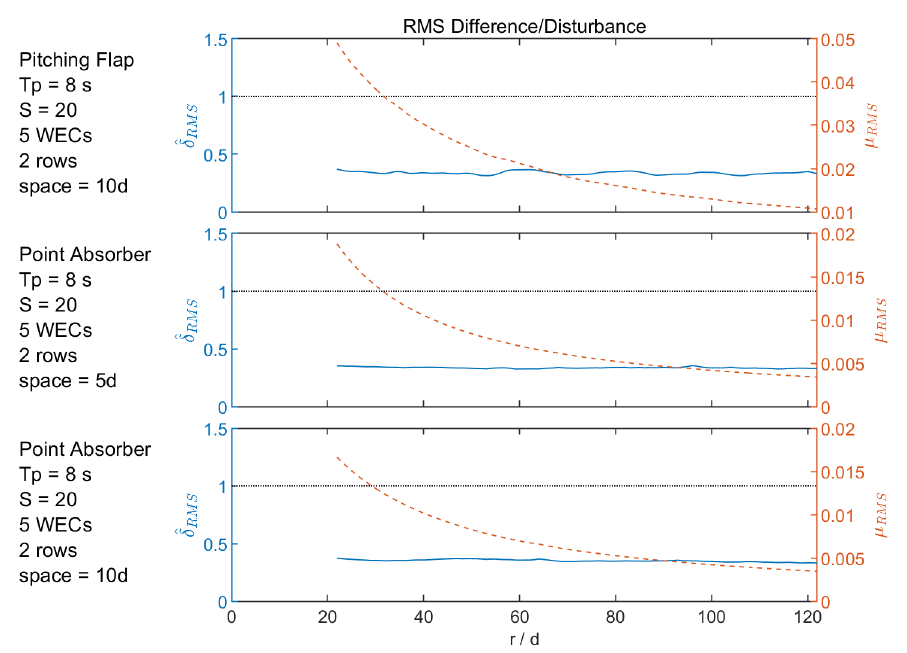
Figure 9. WEC Array RMS difference/disturbance: normalized RMS difference, RMS disturbance, and plot of values over concentric circles as a function of radial distance.